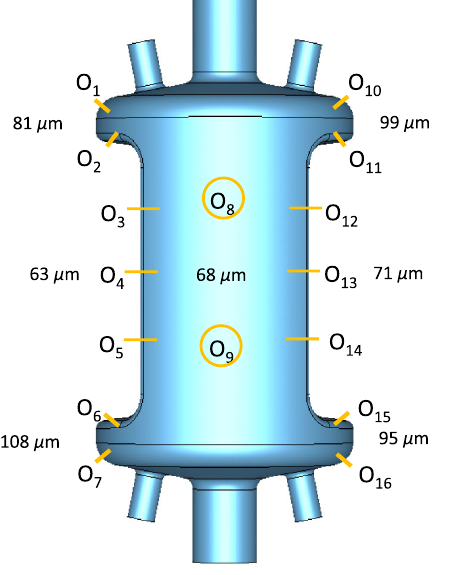
FIG. 6. Average surface removal measured with an ultrasonic probe from the bulk BCP process.